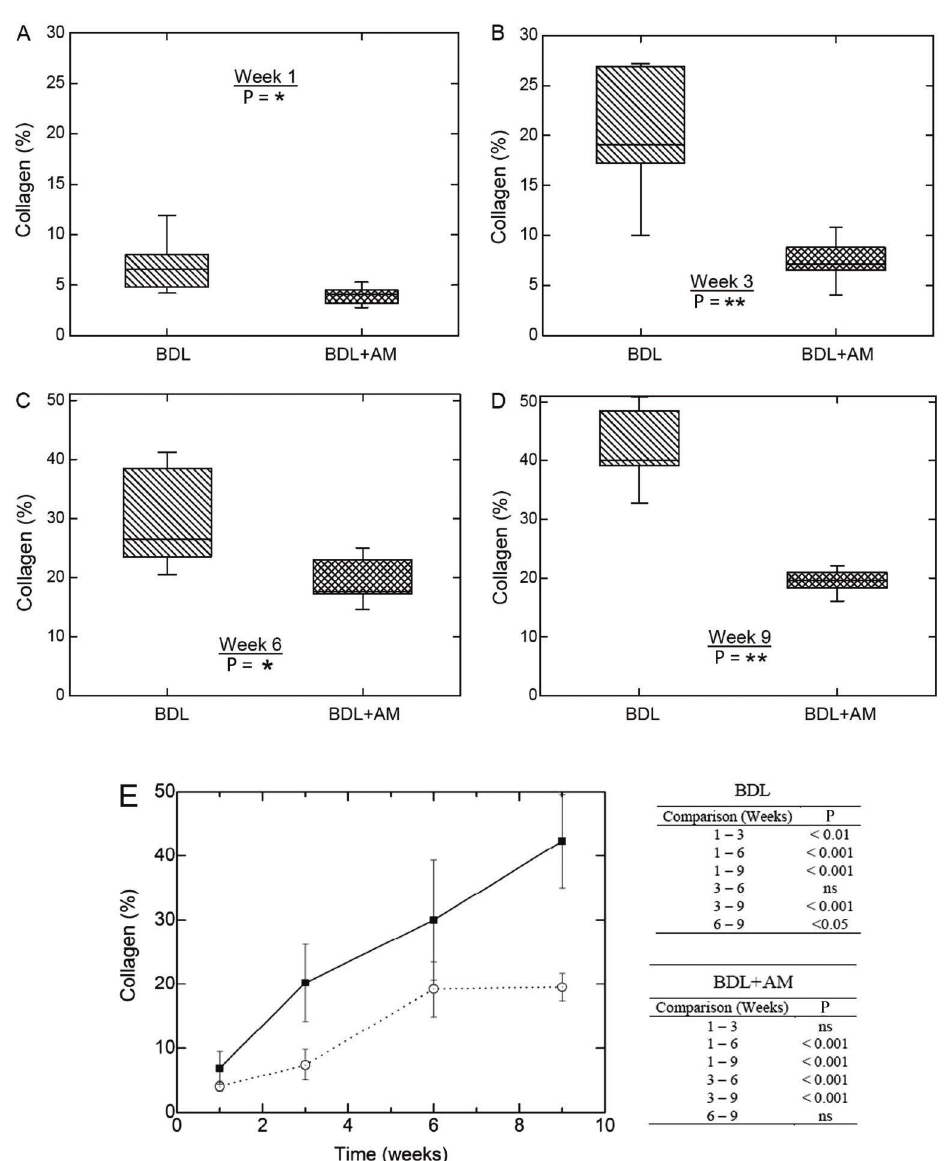
Figure 6. Quantitative evaluation of collagen deposition. Median with interquatile range of collagen deposition in the experimental groups BDL and BDL + AM at week 1 ( A ), week 3 ( B ), week 6 ( C ), and week 9 ( D ) after fi brosis induction. *P o 0.05; **P o 0.01, unpaired Student ’ s t -test. E , Means ± SD of collagen deposition progression in BDL (squares) or BDL + AM (circles) groups at different time points. The tables represent the signi fi cance between time points in BDL and BDL + AM groups, respectively (one way ANOVA followed by Tukey ’ s multiple comparisons test, ns: not signi fi cant). BDL: bile duct ligation; AM: amniotic